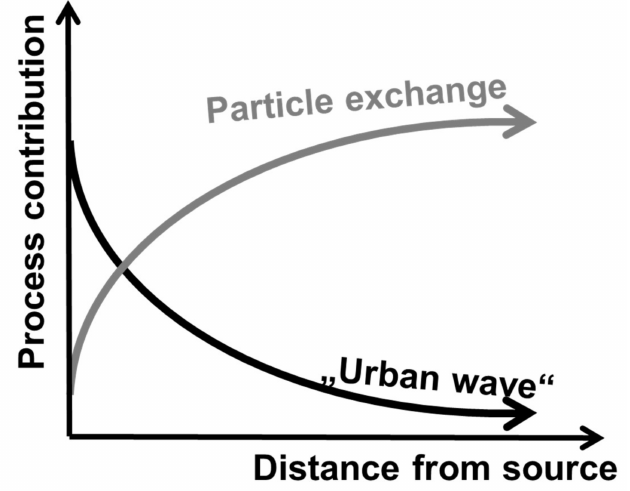
Figure 5. Development of suspended particle signature along the longitudinal profile. Exchanged particles are expected to increase with increasing distance from the sewer system, whereas the impact from the urban areas (“urban wave”) is expected to decrease along the longitudinal profile.